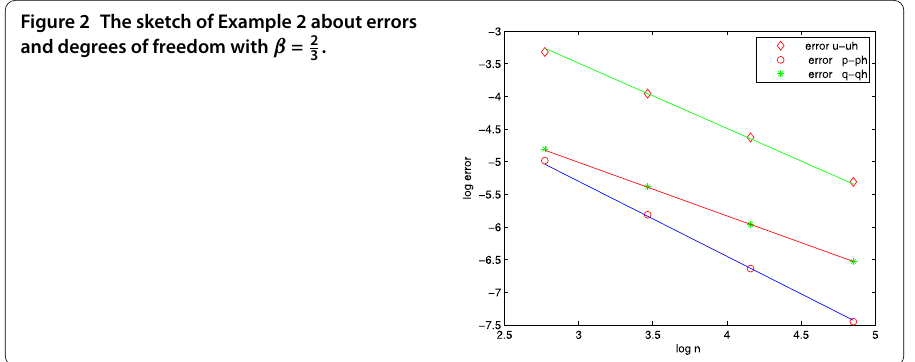
Figure 2 The sketch of Example 2 about errors and degrees of freedom with β = 2